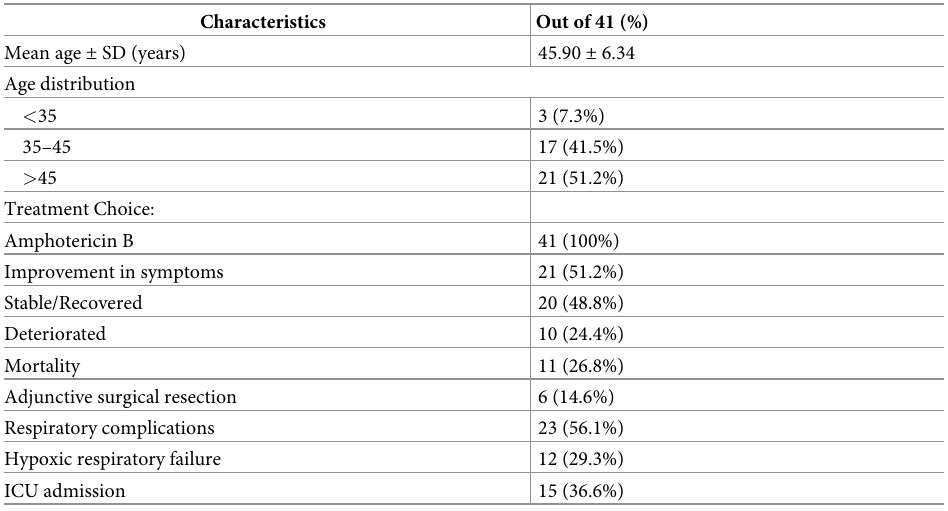
Table 4. Impact on prognosis of patients with